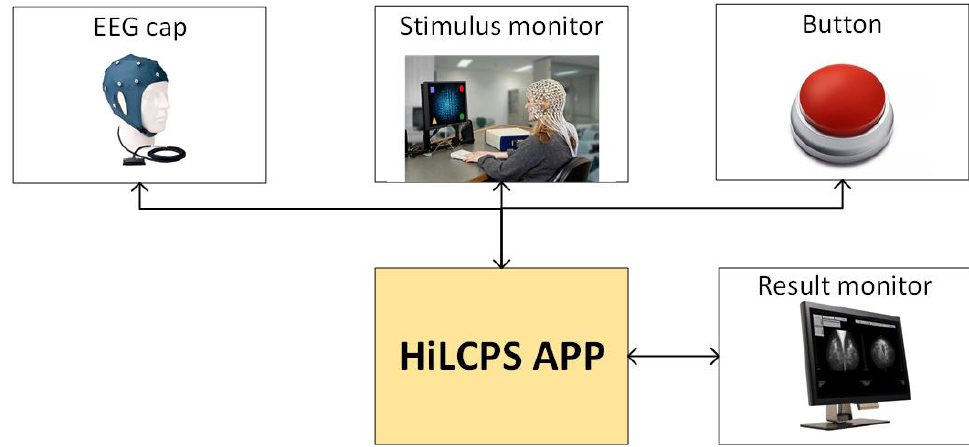
Figure 4. A hypothetical application structure of an EEG system built upon the HiLCPS framework.